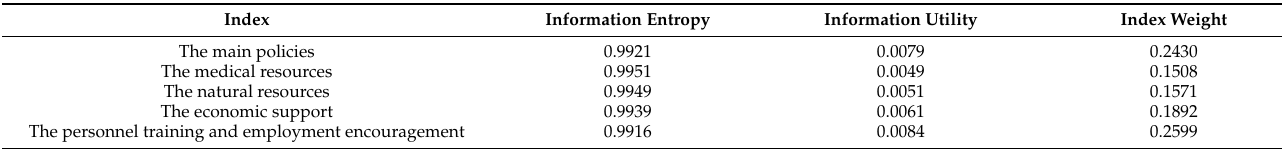
Table 4. The related calculation results of the index